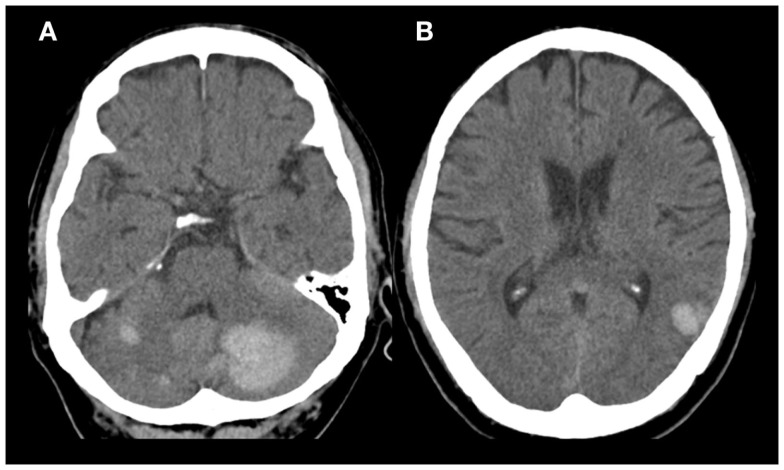
Non-contrast brain CT scan 1 day after thrombolysis. (A) Round shaped (3.1 cm × 3.2 cm × 2.3 cm) hyperdense lesion occupying the left cerebellum and foci of hyperdense lesion in right cerebellum. (B) Foci of hyperdense lesion in left temporal lobe.